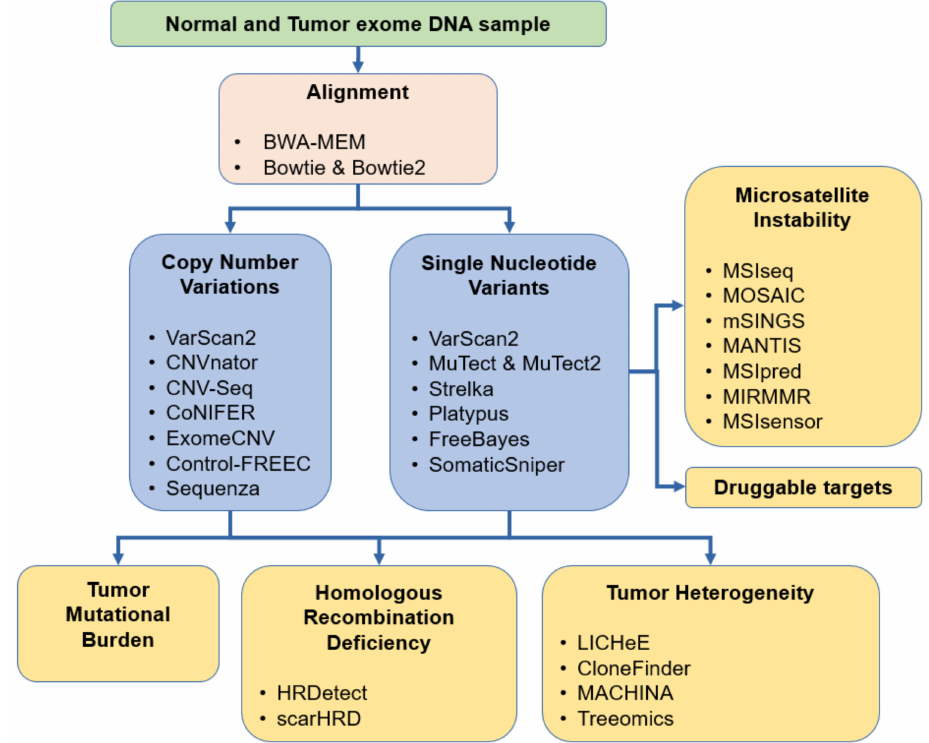
Figure 3. Overview of the most common methods for aberration detection useful in cancer